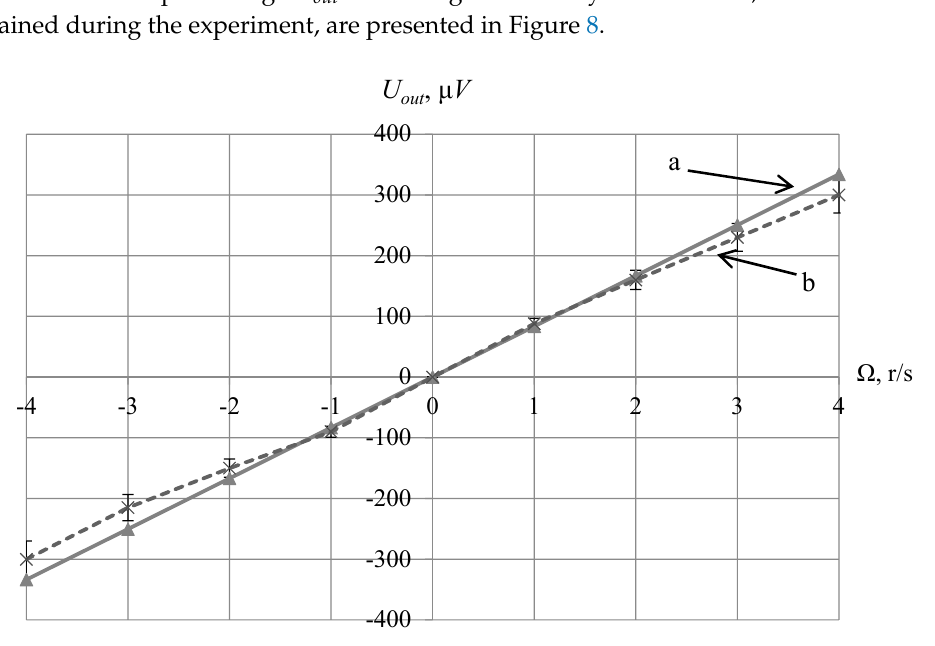
Figure 8. The dependence of the output voltage on the angular velocity of rotation: theoretical ( a ) and experimental ( b ) results.